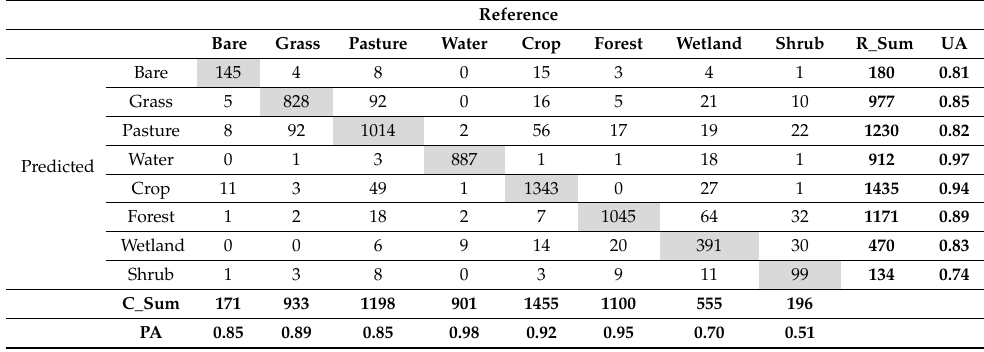
Table 2. Error matrix for the ensemble CNN.